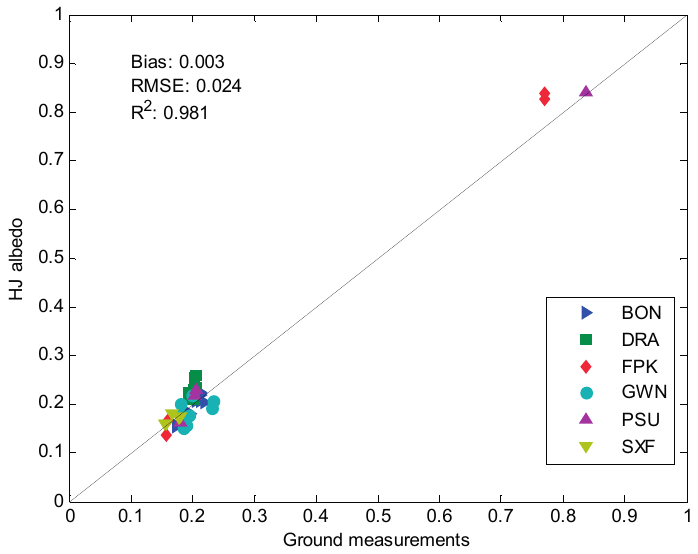
Figure 6. Comparison of HJ shortwave albedo and ground measurements at six SURFRAD sites ( n = 49). Because surface albedo is strongly correlated with land cover type, it is therefore useful to further examine the results by breaking down the validation samples into different land covers, namely forest, grassland/cropland, and open shrub/woody savanna (Table 3). The forest sites observed low surface albedo and often high landscape homogeneity. Thus, surface albedo estimation achieved the lowest bias and RMSE at the forest sites among the three land cover classes. As the vegetation canopy fraction decreases, surface albedo gradually increases. Validation uncertainty of surface albedo can be affected by the increased surface heterogeneity as a result of different combinations of vegetation and background soil fractions. Albedo estimates at the grassland and cropland sites were found to have a slight negative bias of 0.018 compared with the ground measurements. At the same time, an overestimation of 0.022 in albedo is associated with the sparsely-vegetated sites. The validation results shown here agree well